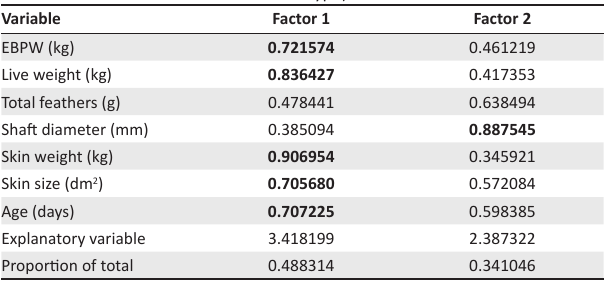
TABLE 10: Individual factor loadings as determined by factor analysis (significant contributions for each factor are in bold type).